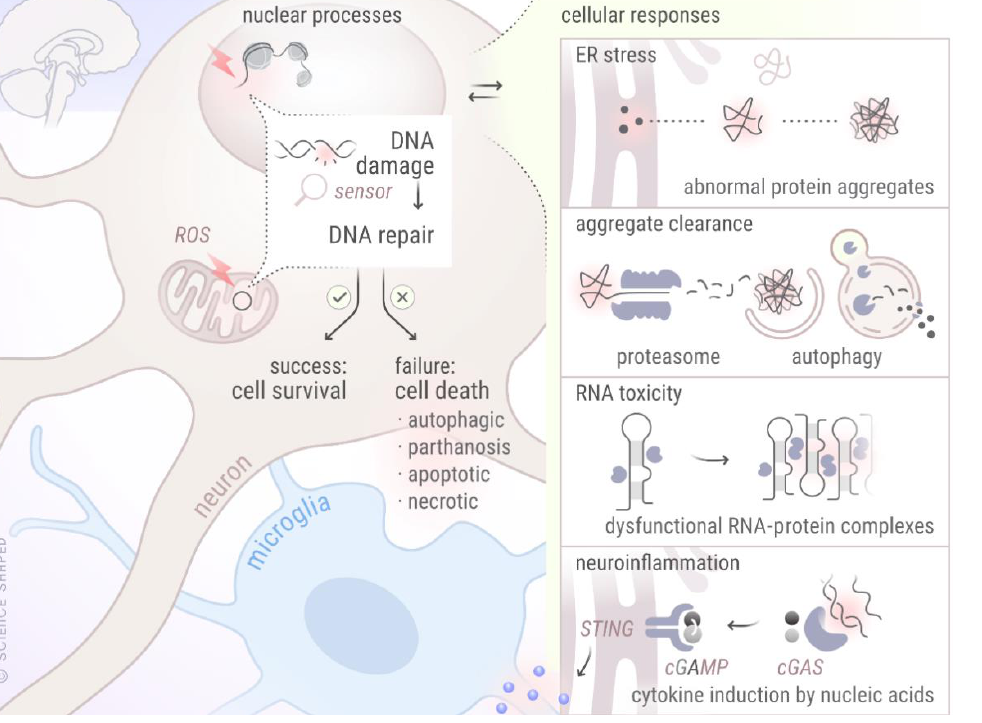
Figure 3. Crosstalk between different cellular mechanisms involved in various NDDs. The figure represents crosstalk between DDR and other cellular processes known to be perturbed in various NDDs. Created by Ellen Tenstad @ScienceShaped